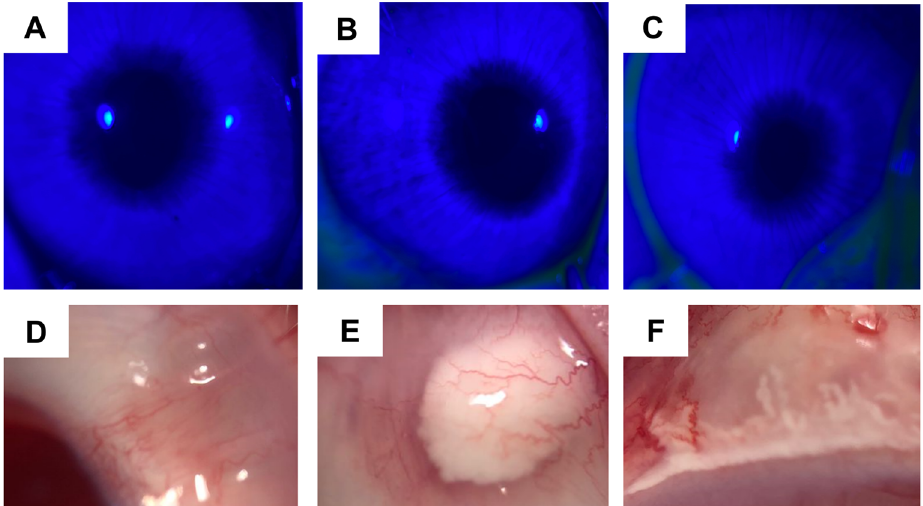
Figure 10. Images of fluorescein staining after 24 h of subconjunctival administration of ( A ) normal saline solution, ( B ) Fortcinolona ® 40 and ( C ) aqueous dispersible TA-NC to evaluate corneal damage. Images of conjunctiva rabbit eye after 24 h of subconjunctival administration of ( D ) normal saline solution, ( E ) Fortcinolona ® 40 and ( F ) aqueous dispersible TA-NC to evaluate conjunctiva redness.